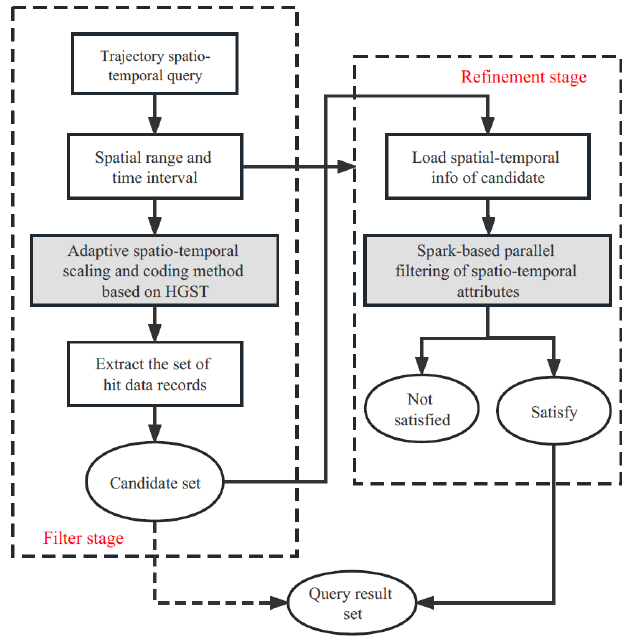
Figure 8. The general framework of spatio-temporal range query.